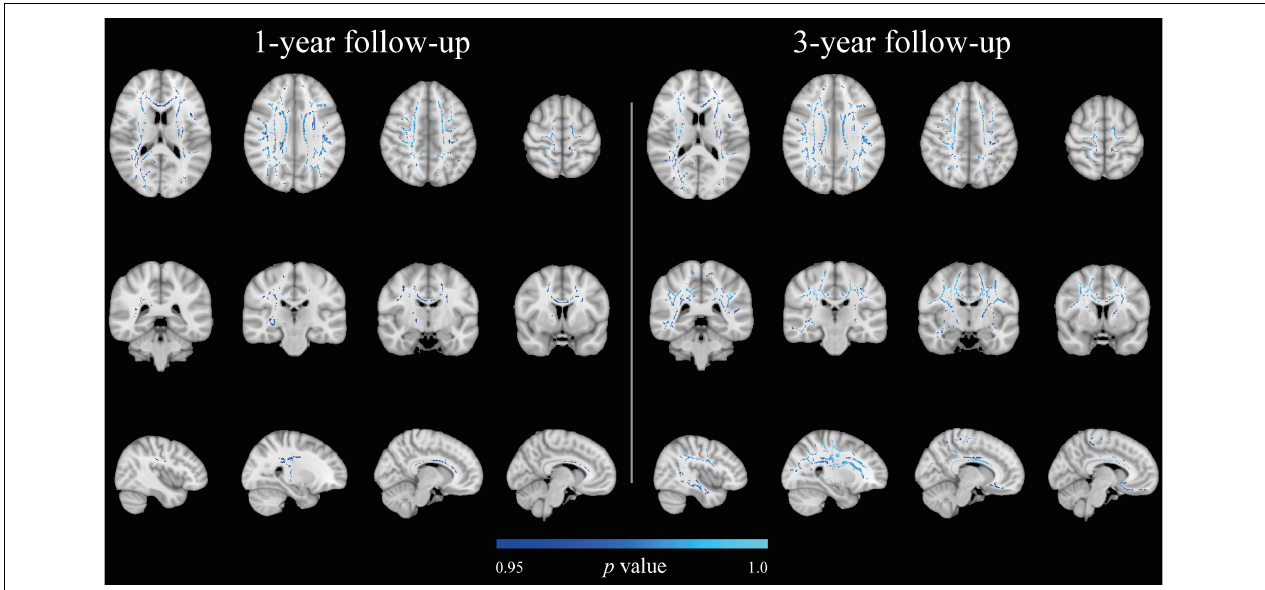
FIGURE 4 | Associations between exercise intensity based on Borg scores and MD at 1- and 3-year follow-ups ( p ≤ 0.05, corrected for multiple comparisons, sex, and age). There were no significant results at baseline and 5-year follow-up. Results are superimposed on the standard MNI 152 1 mm template on radiological convention. Negative relationships are depicted in blue-light